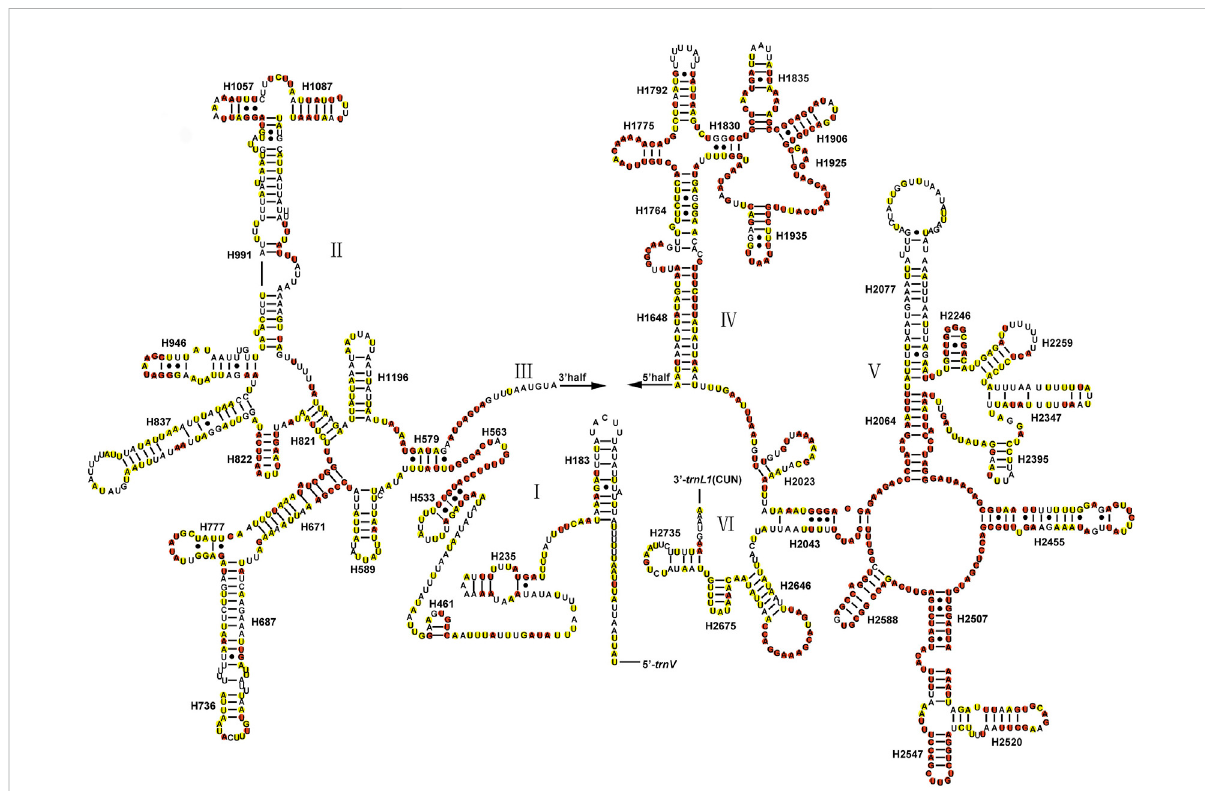
FIGURE 6 The potential secondary structure of the 16S rRNA in Gonopsis coccinea . Conserved sites are marked red in Pentatomidae and yellow in Phyllocephalinae.